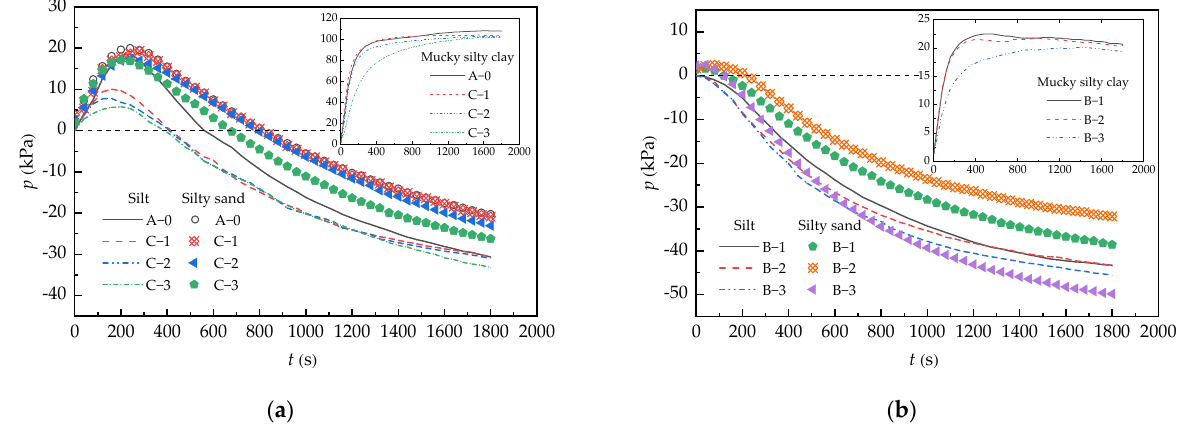
Figure 7. Pore pressure development of different soils under different stress paths. ( a ) Groups A and C; ( b ) Group B.